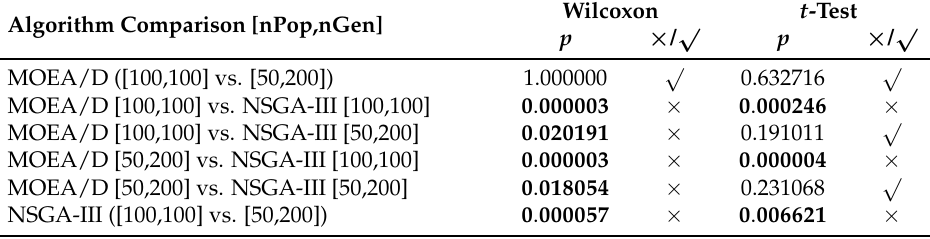
Table 5. p -values and acceptance/rejection of the Wilcoxon test and t -test for the multi-objective results of the Positive Inverse Generational Distance (IGD+) for 15 independent executions. Algo- rithms with statistical differences are in bold. × indicates that the left algorithm is better than the √ right one, while indicates that there is not a significant difference between